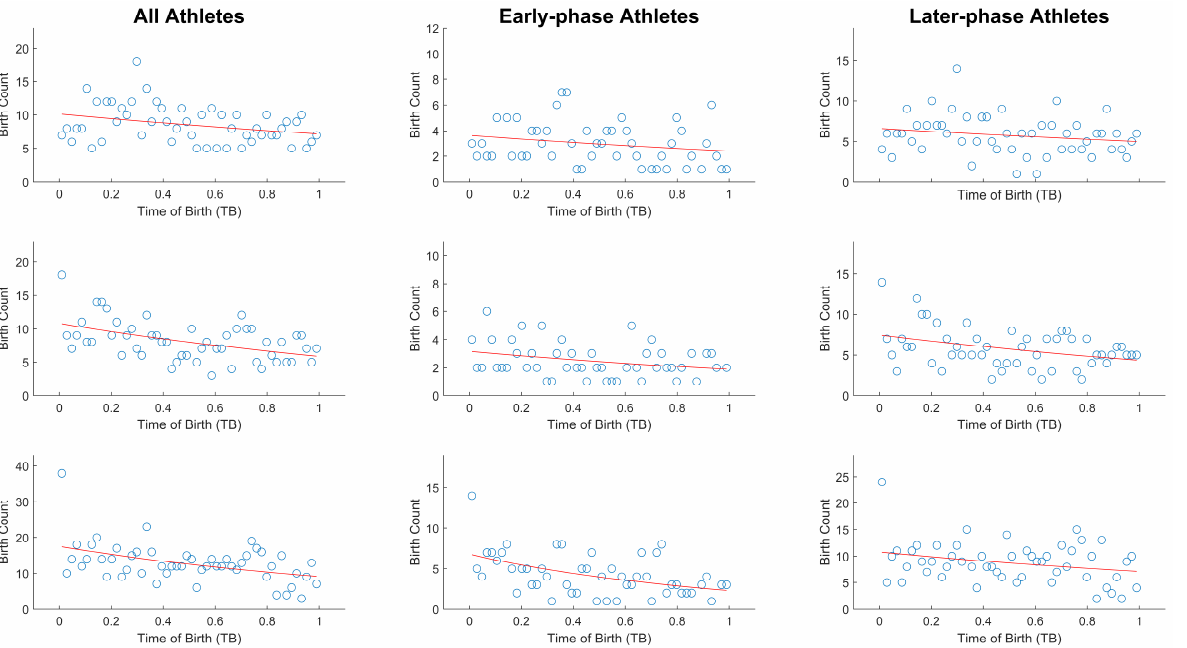
Figure 1. Scatter-plots of relative birth frequency by week considering all players and “early phase” and “later phase” players for basketball, volleyball, and soccer. The red line represents the best fit of the Poisson regression modeling.